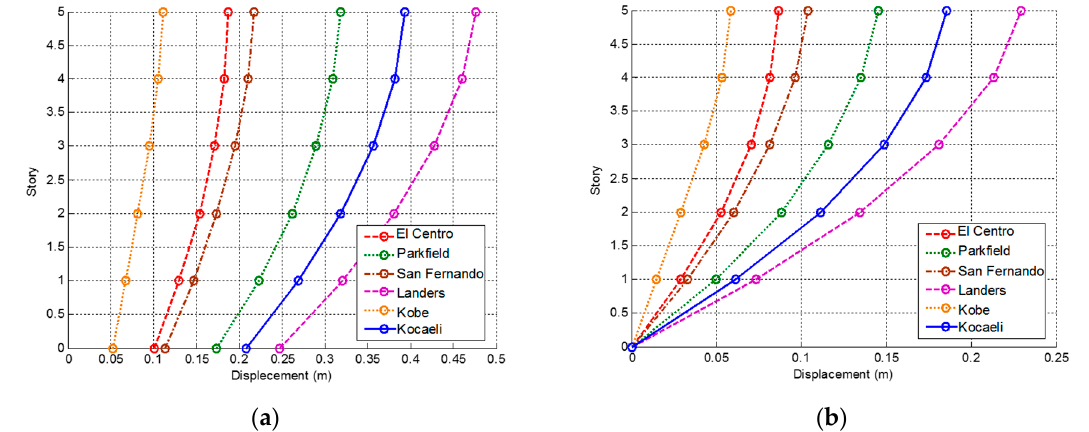
Figure 10. The results of ( a ) peak absolute displacement and ( b ) peak relative displacement for different stories of building with base isolation system.